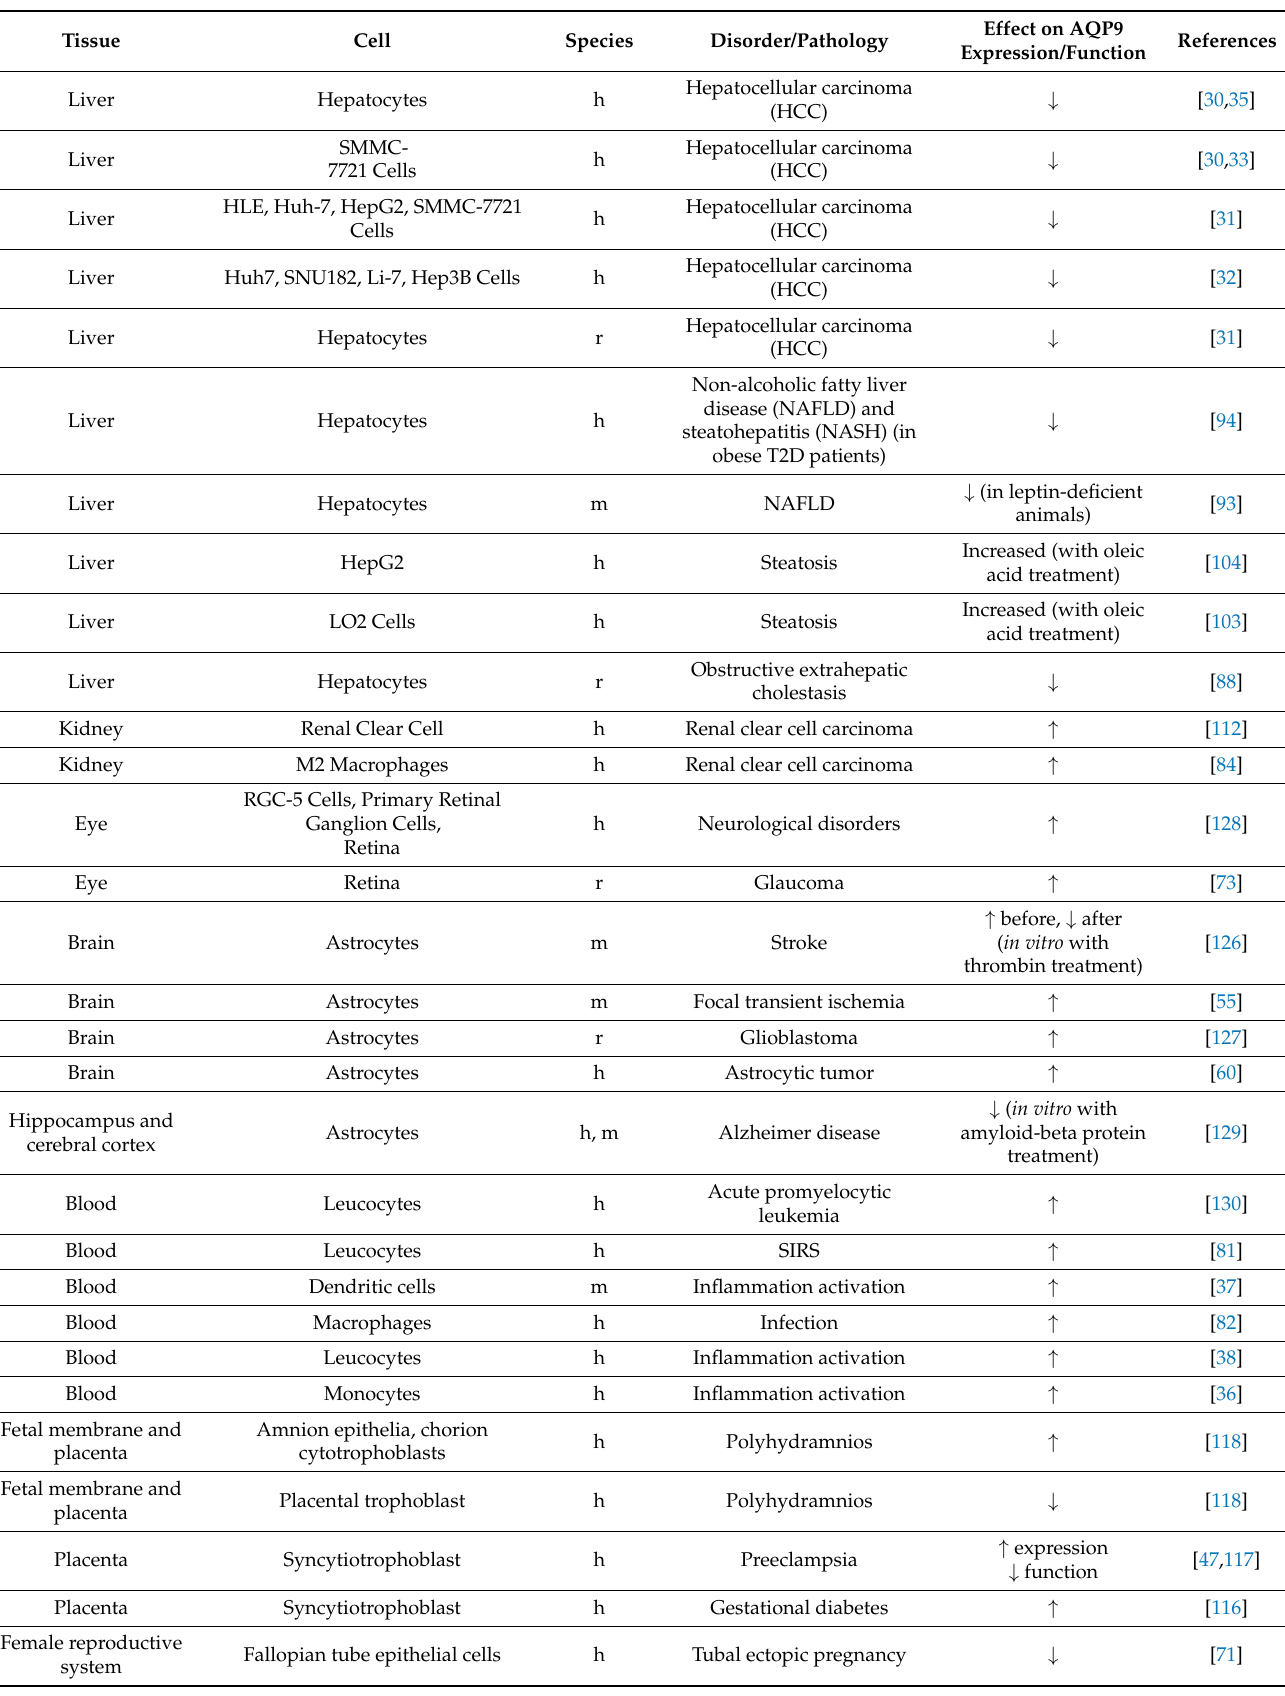
Table 2. AQP9 involvement in diseases where it has potential to become a clinical